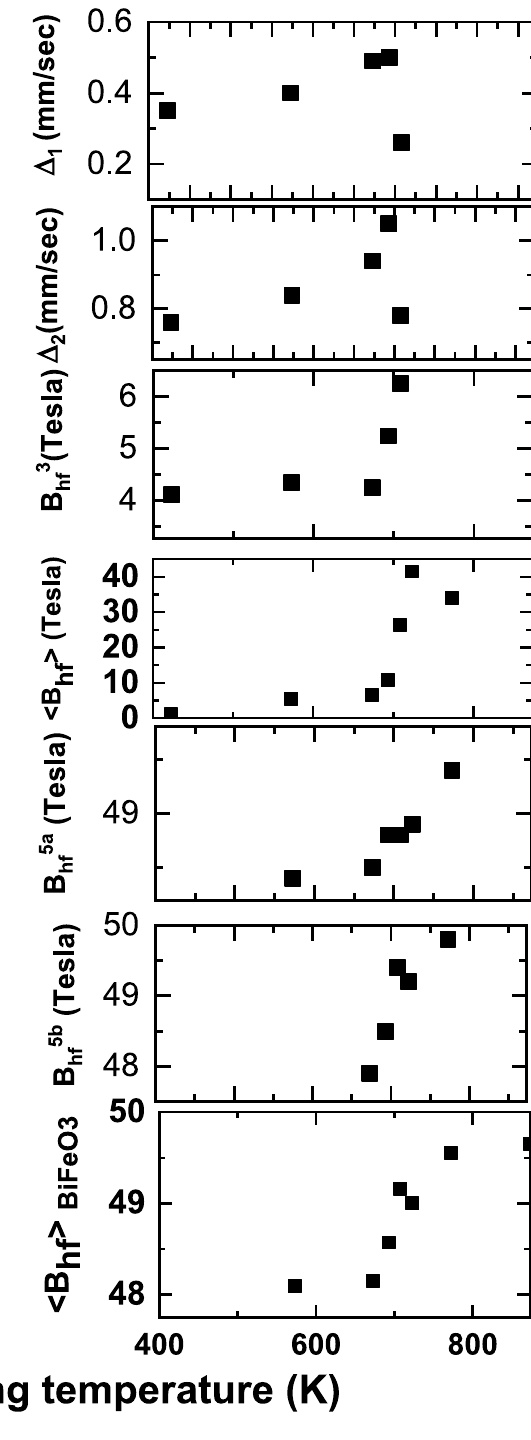
Figure 6. Variation of M ӧ ssbauer results corresponding mainly to Fe atoms associated with BiFeO 3 with respect to calcination temperature. Based on the Mossbauer results the stages (I) and (II) are understood to be due to nucleation, growth and the formation of nanocrystalites of BiFeO 3 respectively. While stage III implies the coarsening of nanocrystallites of BiFeO 3 in to polycrystalline phase. Mossbauer study brings out that the importance of the stage II leading to the formation of nanocrytallites of BiFeO 3 in large fraction close to 0.8 along with the elucidation of the evolution of hyperfine parameters such as hyperfine field with calcination temperature in this intervalmarking an increase in crysallite